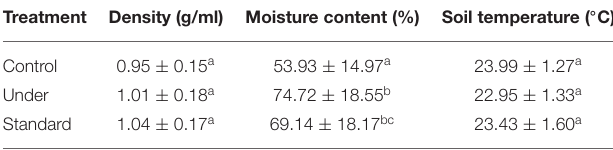
TABLE 1 | Ancillary variable affecting GHG emissions measured at the study